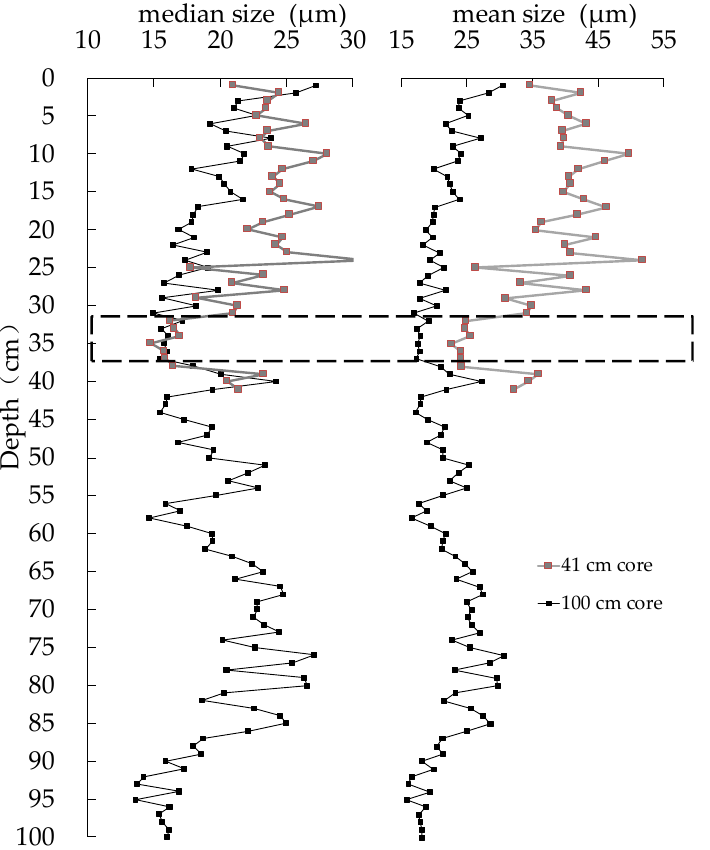
Figure 6. Profiles of the sed-